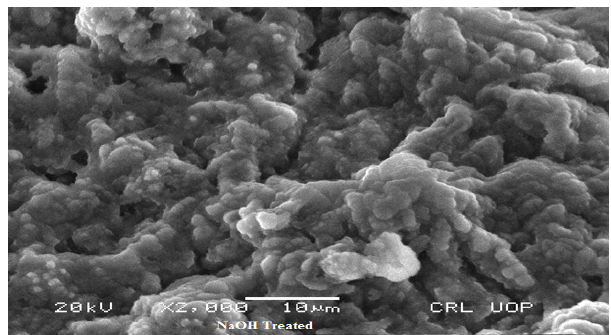
Figure 17. NaOH-treated CR .